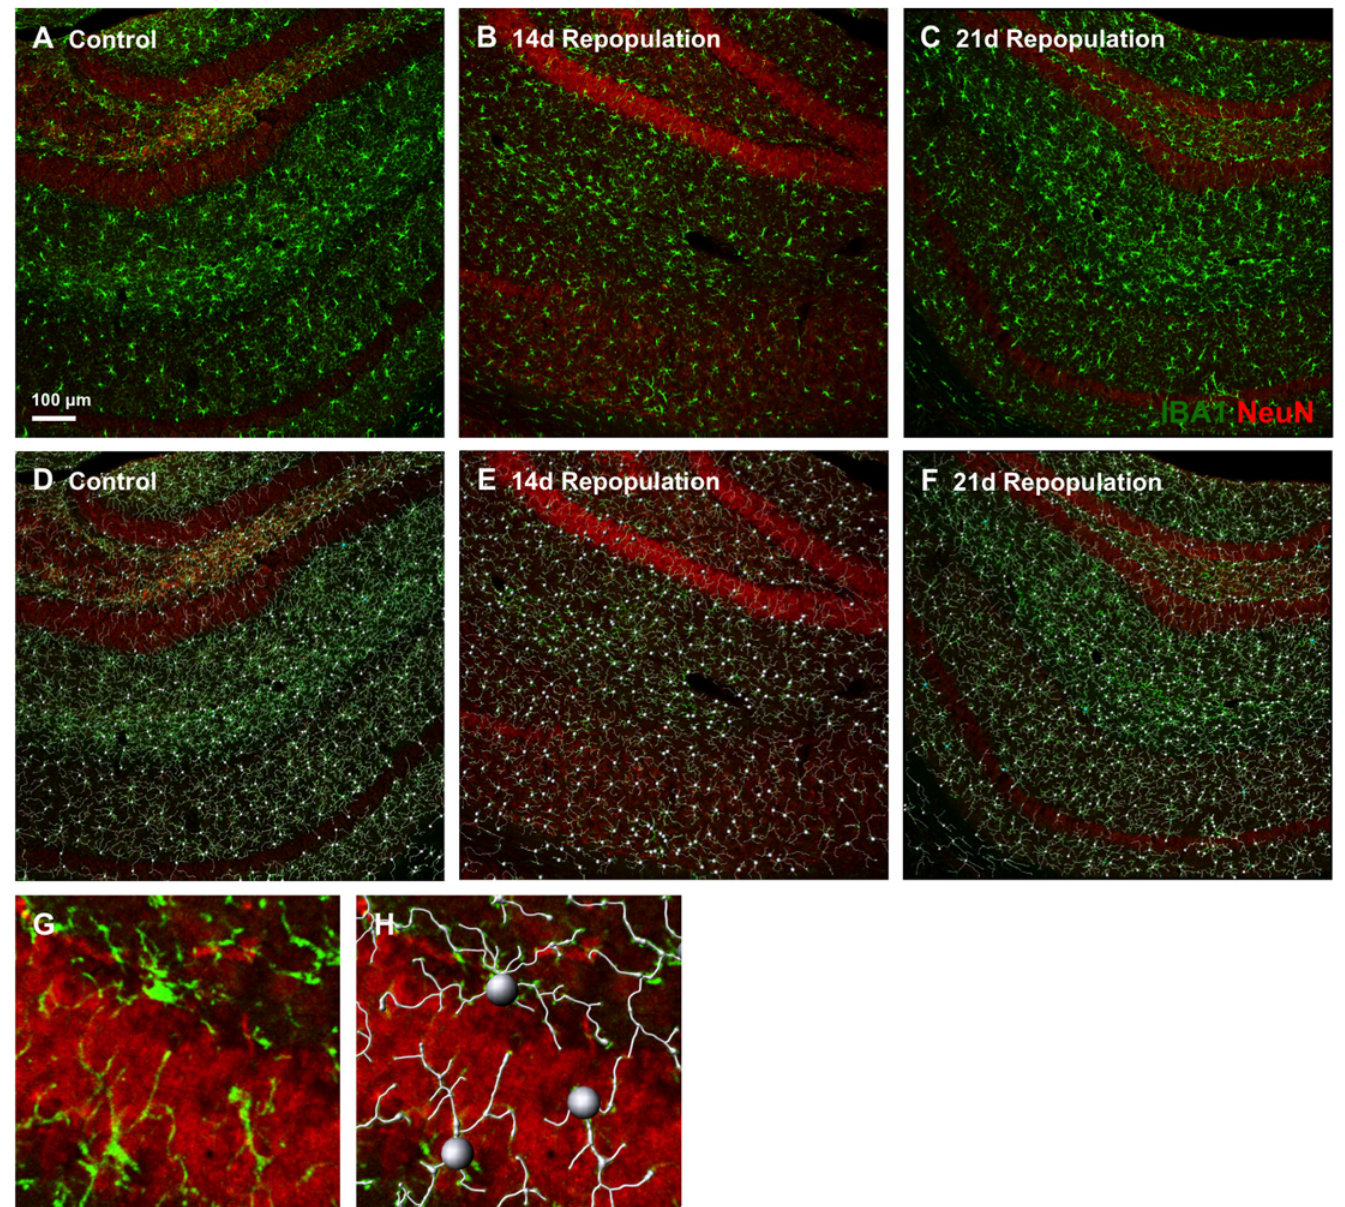
Fig 3. Microglial Modeling for Morphological Analysis. A – G) Examples of microglial modeling in the hippocampus of control, 14 d repopulation, and 21 d repopulation treatments are shown. 10x zoom images were analyzed with Imaris software. NeuN staining is shown in red and IBA1 in green. A – C) Reference images of the hippocampus for each treatment with microglia are shown in green. D – F) Modeling of the microglia with cell bodies and processes traced in white, as determined by the computer software, show nearly identical overlap with the reference images from (A – C). G, H) Zoom image of the microglial modeling from the 14 d repopulation